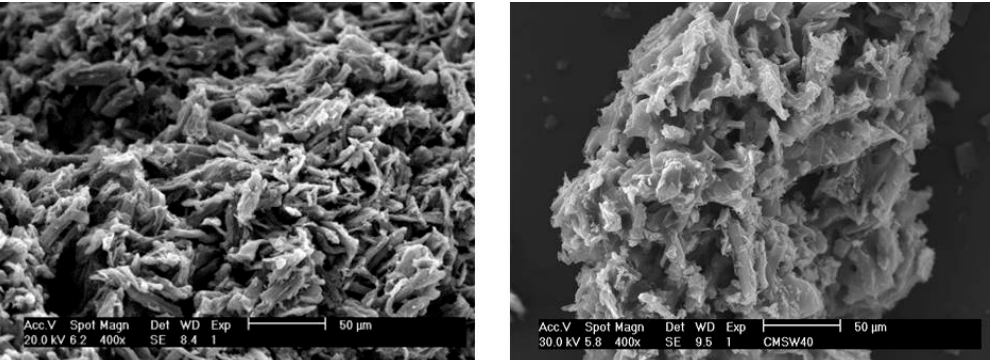
Figure 2 . SEM images of carbons from microcrystalline cellulose and different amounts of wheat starch: 10 wt. % ( left hand side ) and 40 wt. % ( right hand side ) .